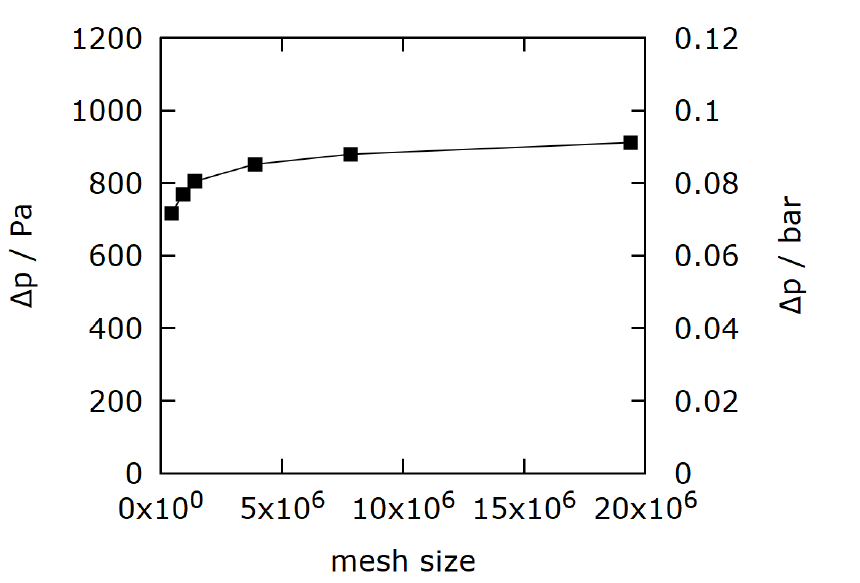
Figure 9. Pressure difference as a function of the mesh resolution for a parallel serpentine plate with a geometric area of 10cm 2 at 0.44Acm − 2